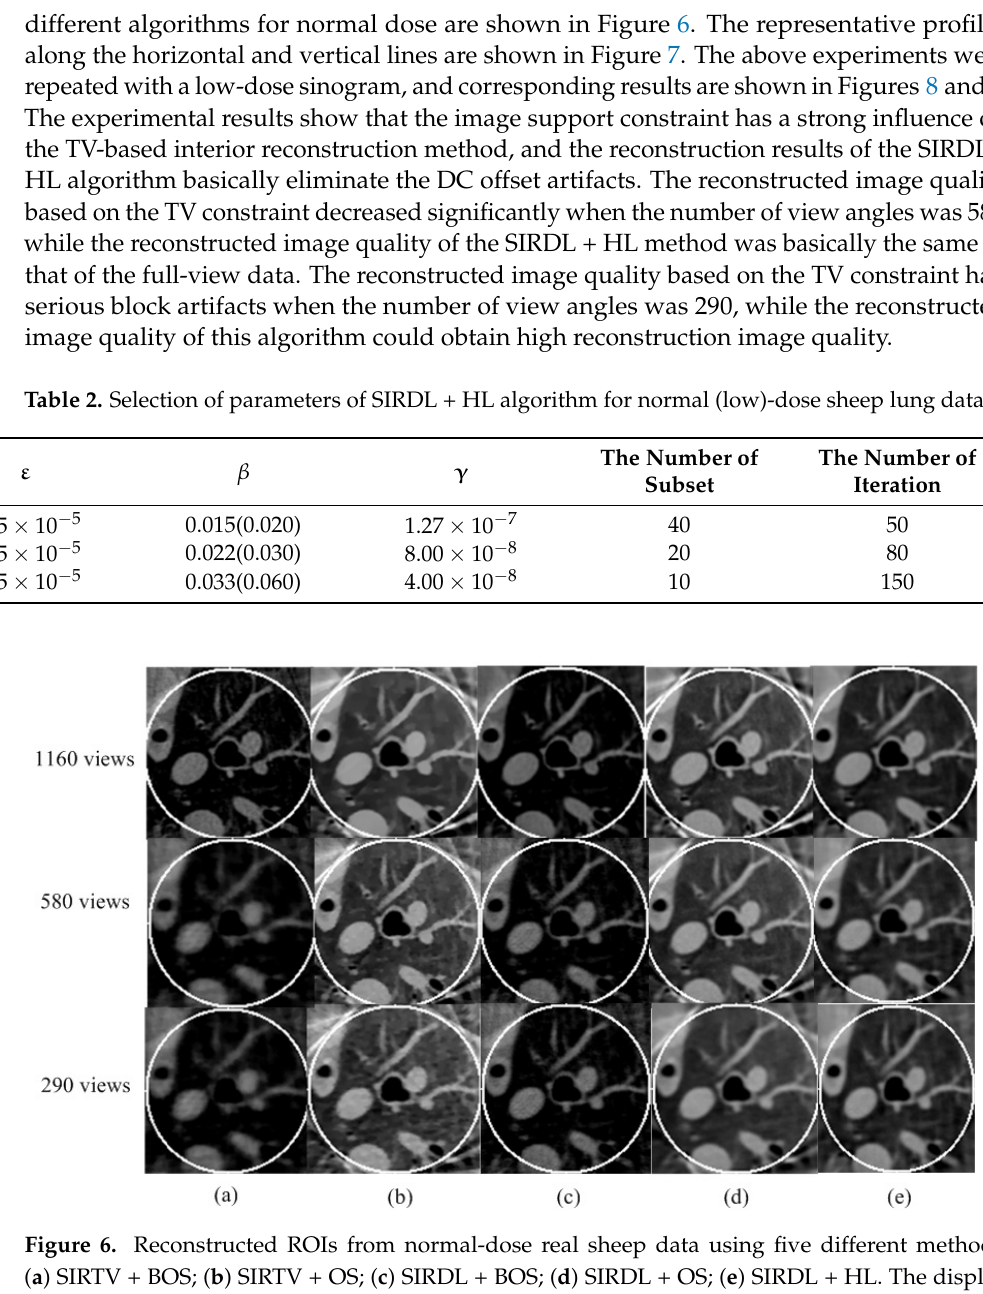
( d ) Figure 7. Profiles plots of ROIs reconstructed from 1160 views in Figure 6: ( a ) Horizontal central line; ( b ) vertical central line; ( c ) local enlargement of rectangle in ( a ); ( d ) local enlargement of rectangle in ( b ).